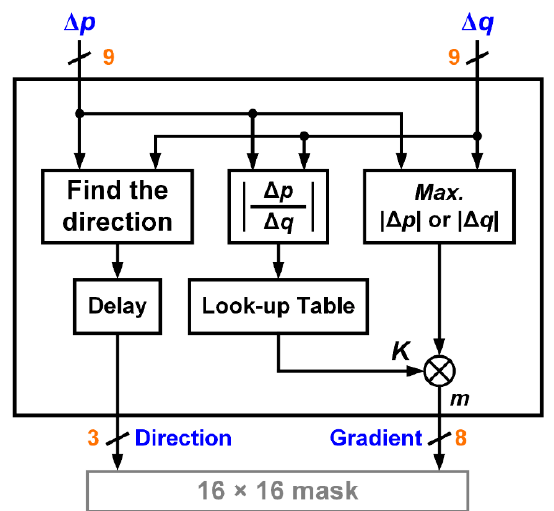
Figure 7. Function blocks of the proposed TI and look-up table approach for determining the direc- tion and gradient of the detection